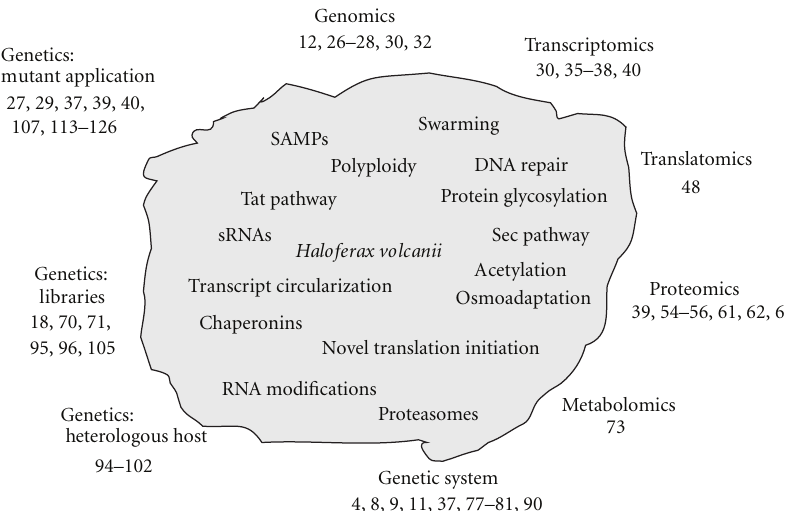
Figure 1: The figure schematically shows the pleiomorphic cell morphology of H. volcanii. Inside of the cell selected topics are listed that are discussed in this review. Outside of the cell the titles of selected chapters of this review are shown together with the respective most important publications (compare reference